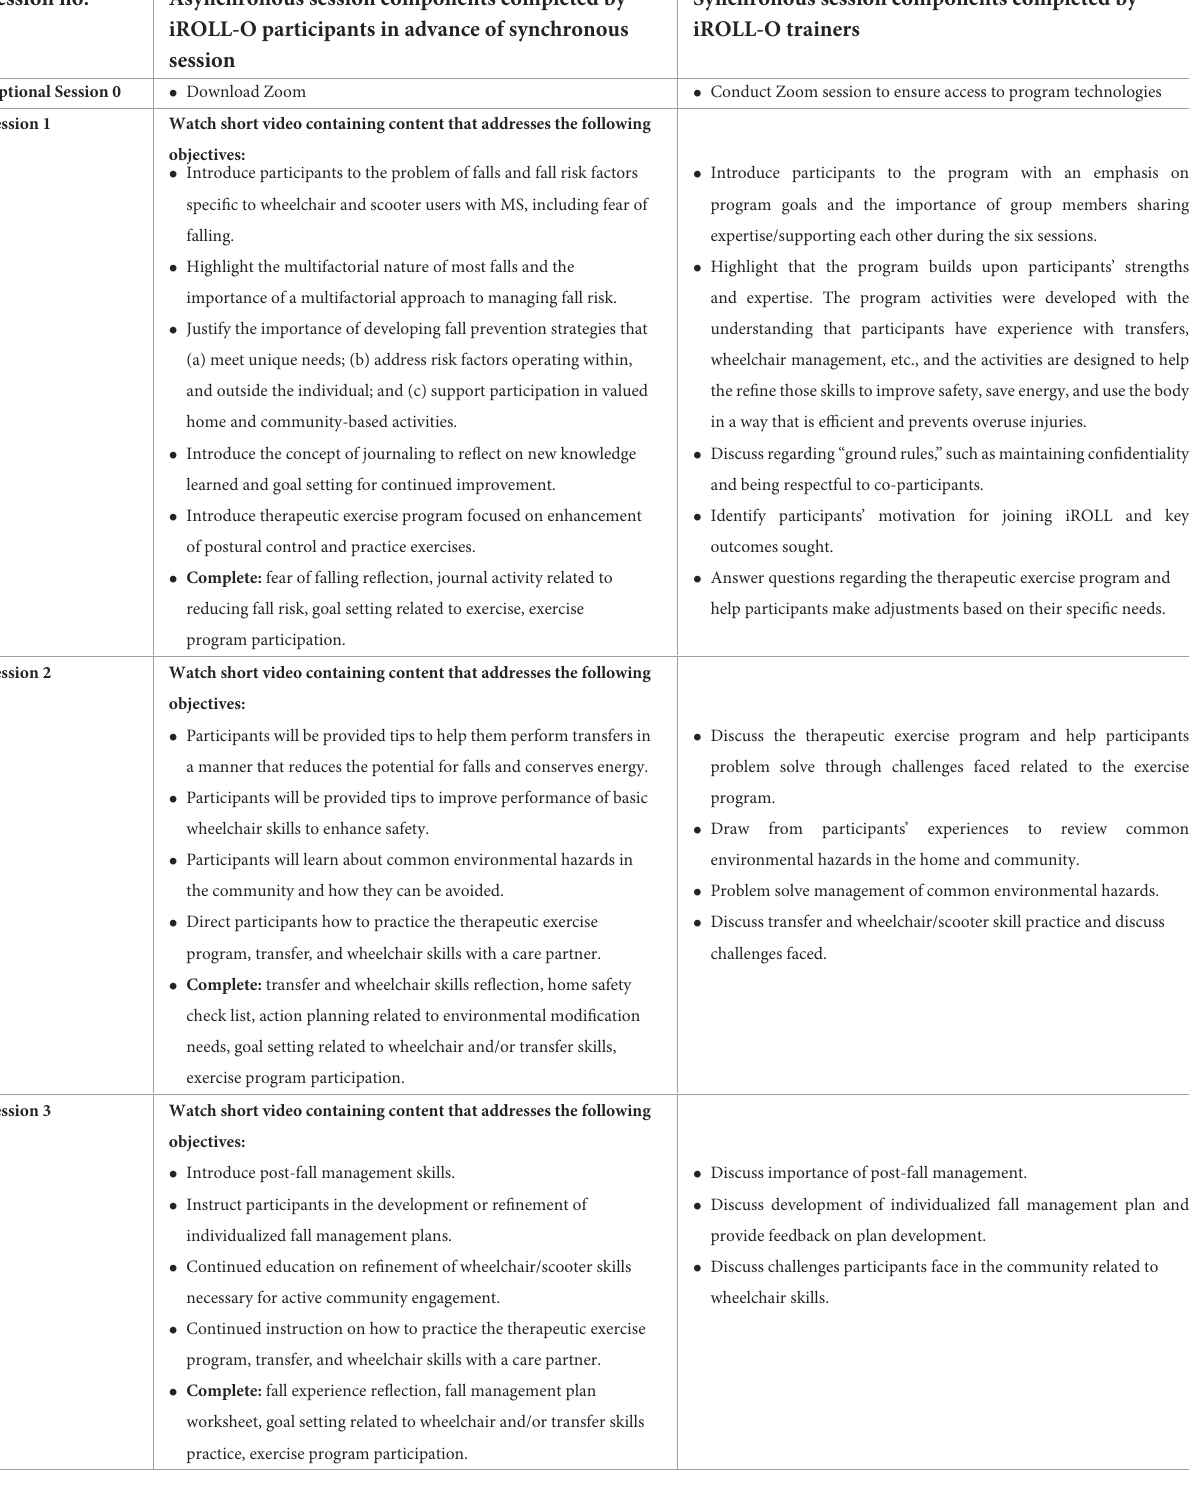
TABLE 1 Synchronous and asynchronous session components for